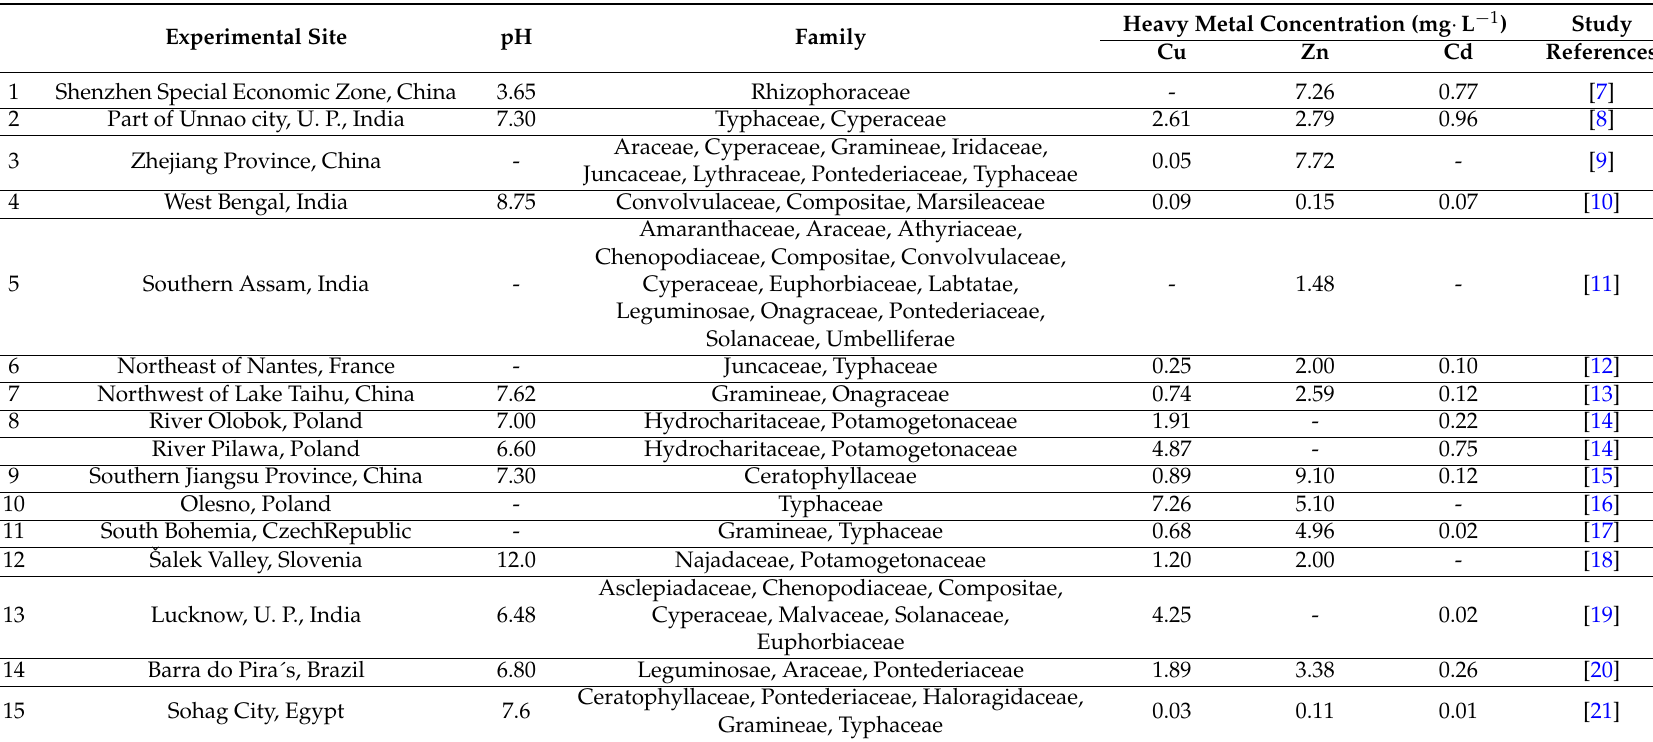
Table 1. Additional information extracted from selected studies to evaluate the effect of aquatic plants on adsorption of Cu, Zn, and Cd. Experimental